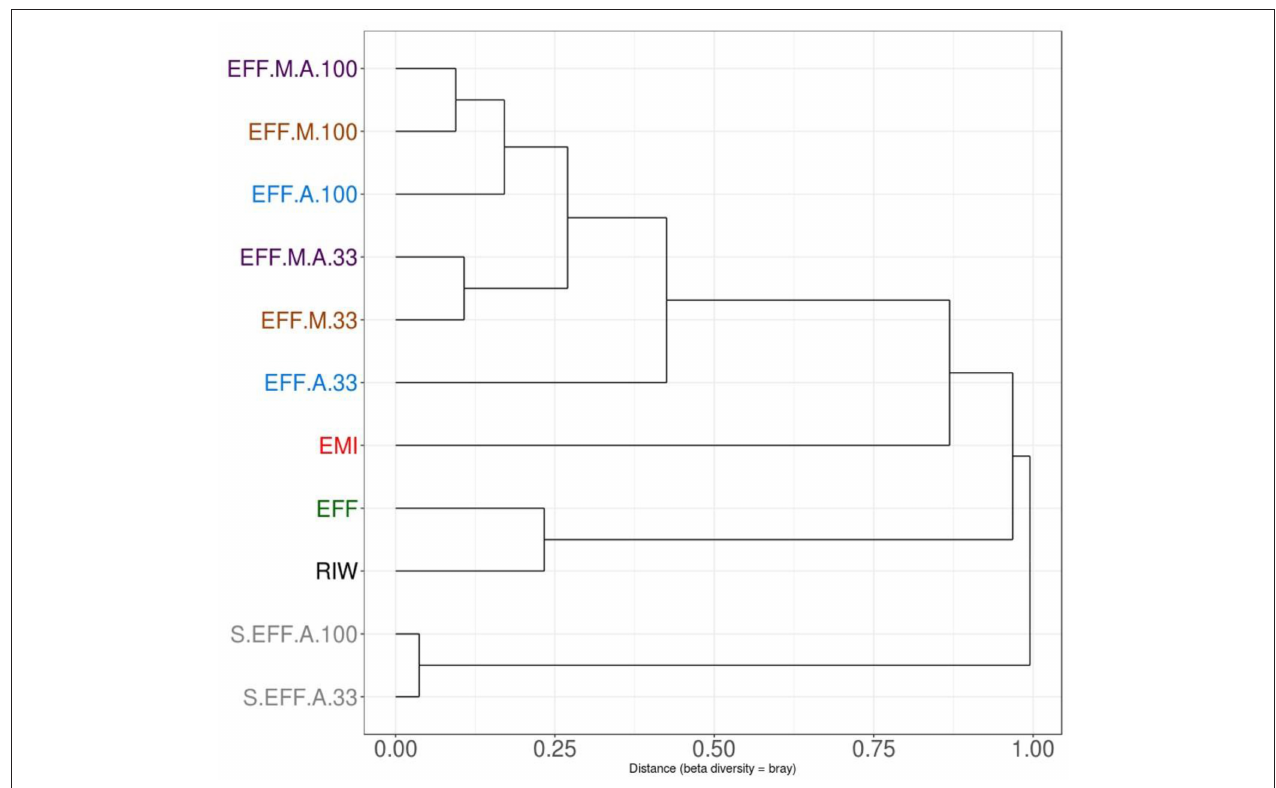
FIGURE 5 | Clustering of samples using the Bray Curtis distance matrix. Samples clustered primarily by dilution rate. Diluted samples clustered together, away from non-diluted samples. Further clustering is seen depending on the presence or absence of enriched microbial inoculum (EMI). Samples which received additional microbial inoculum had a similar taxonomic profile compared to samples that received only algae